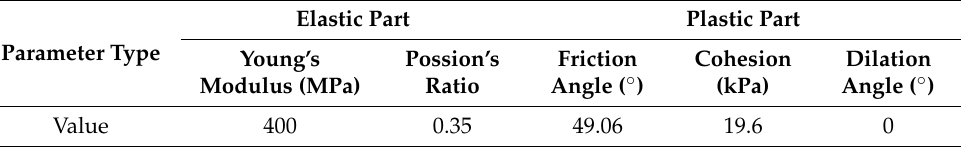
Table 2. Parameters of Mohr-Coulomb model.